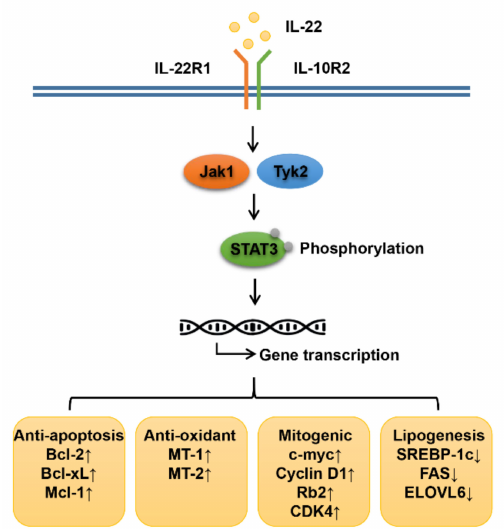
Figure 2. Protective mechanisms of IL-22 on NAFLD. Once interacting with its heterodimeric receptor complex IL-22R1 and IL-10R2, IL-22 induces activation of Jak1-Tyk2 kinases and STAT3 phosphorylation. IL-22 then provokes multiple downstream gene expression, including antiapoptotic, antioxidant and mitogenic genes. IL-22 also modulates lipid metabolism by enhancing lipolysis while relieving lipogenesis in STAT3-dependent